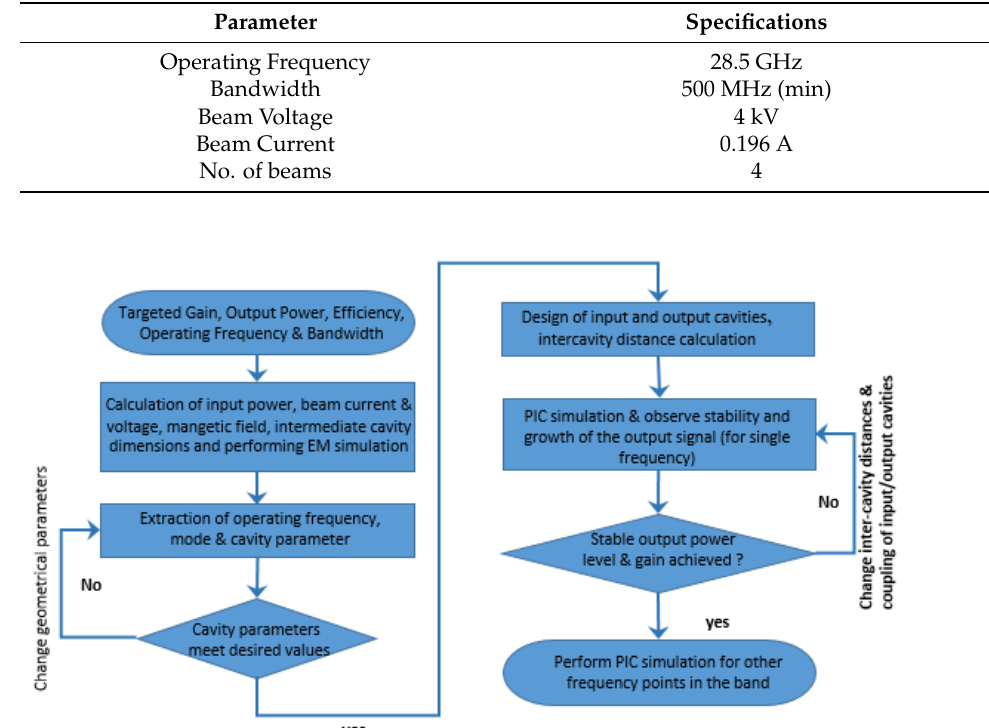
Table 1. Design specification of proposed multiple beam klystron .